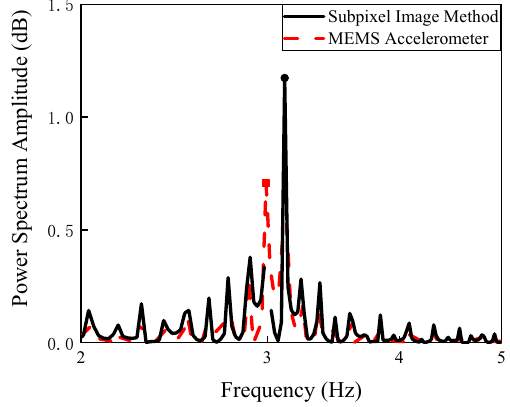
Figure 14. Natural frequency of the undamaged steel beam through the MEMS accelerometer and subpixel image method.